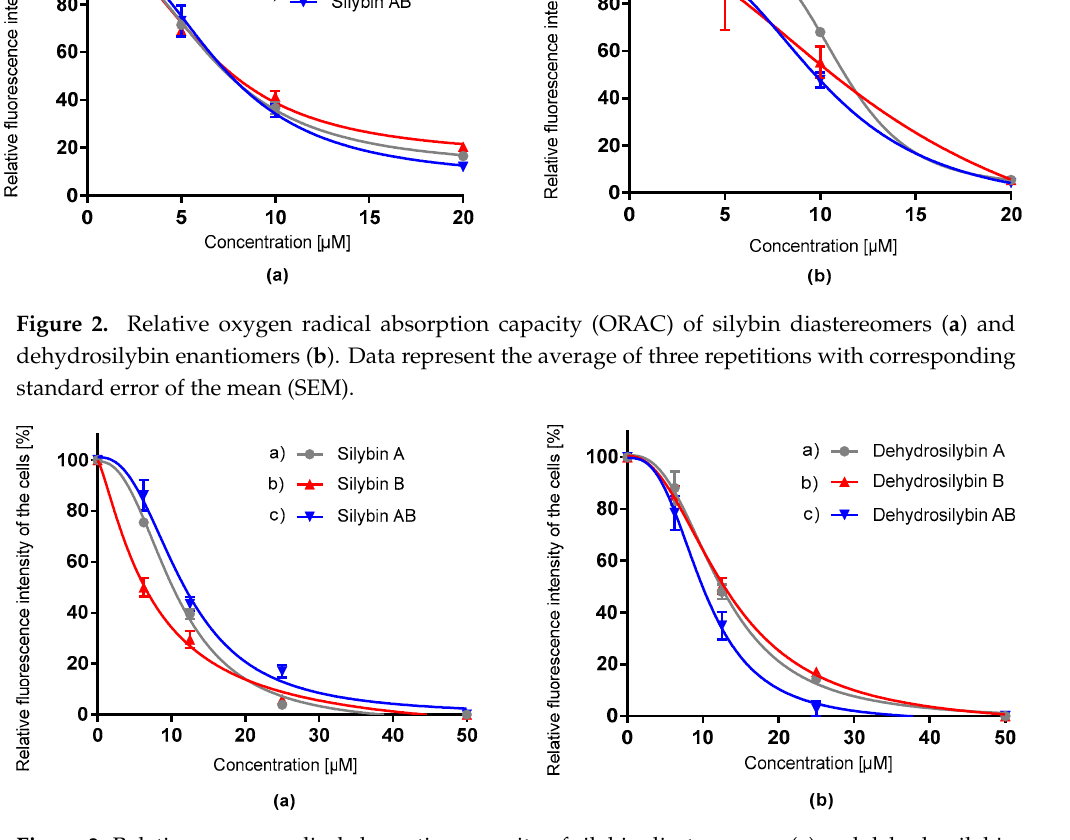
Figure 3. Relative oxygen radical absorption capacity of silybin diastereomers ( a ) and dehydrosilybin enantiomers ( b ) in cellular antioxidant activity assay (CAA, human hepatocellular carcinoma HepG2 cell line). Data represent the average of three repetitions with corresponding standard error of the mean. Table 1. Relative oxygen radical absorption capacity of silybin and dehydrosilybin diastereomers.